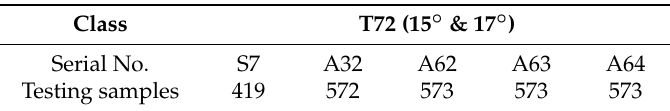
Table 8. Dataset of EOC-2 (version variants).